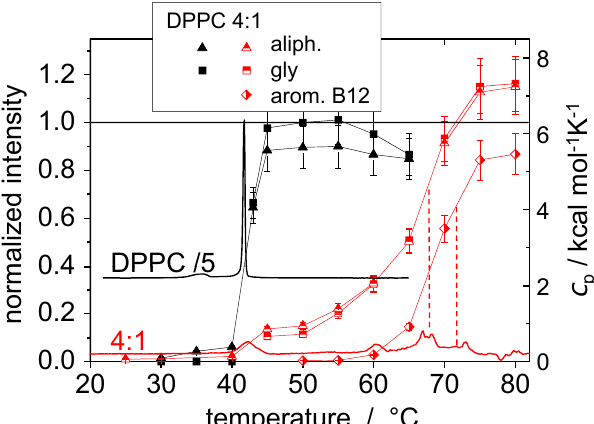
Figure 4. Temperature-dependent proton integrals (left scale) and differential scanning calorimetry (DSC) curves (right scale) for pure DPPC and the mixture DPPC/B12 4:1. The glycerol resonance measured for the pure DPPC sample was used as reference intensity for all peak integrals. Figure adapted with permission from ref. [22]. Copyright 2015 John Wiley&